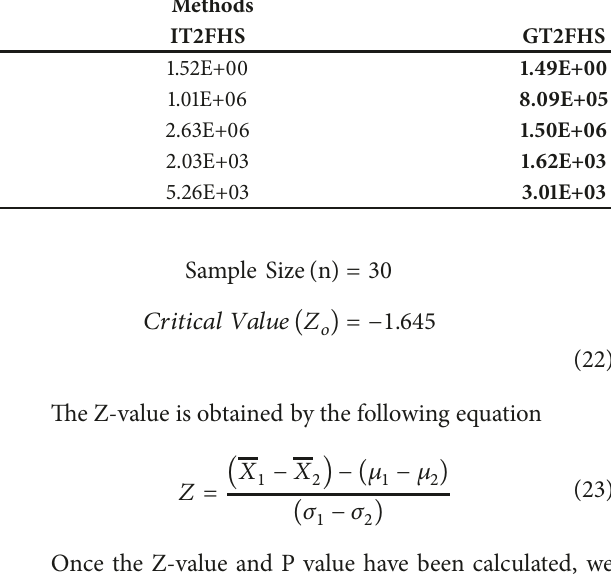
GT2FHS, IT2FHS, and FHS methods without